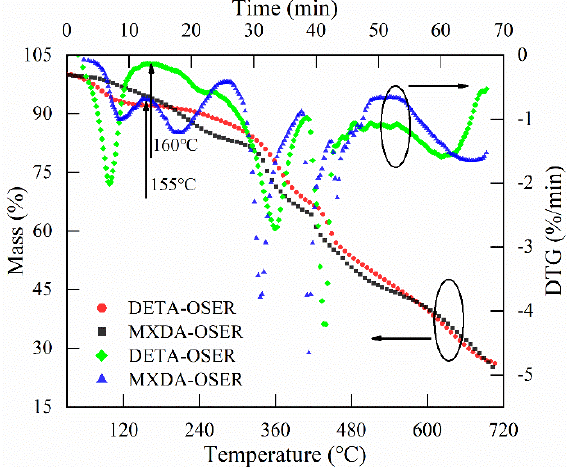
Figure 8. TGA and DTG curves of the samples of DETA-OSER and MXDA-OSER in air. The samples were made of the aged sol after drying the solvent at 60 °C, and they were not cured at a high temperature.